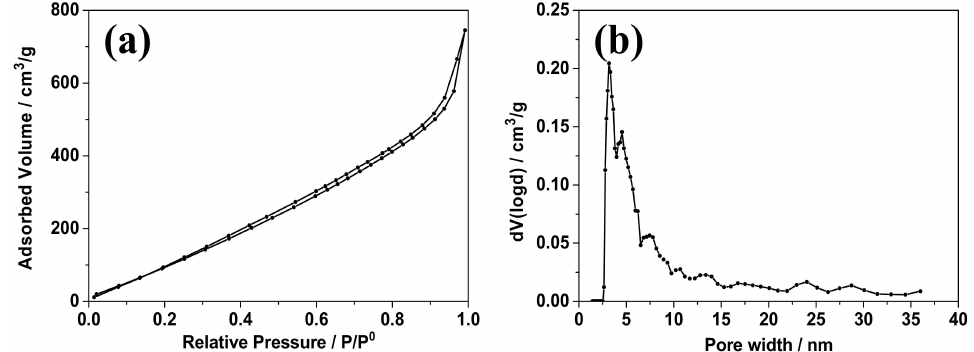
Figure 4. Nitrogen adsorption–desorption isotherms ( a ) and the corresponding Barrett–Joyner–Halenda (BJH) desorption pore size distribution ( b ) of the ZnCo 2 O 4